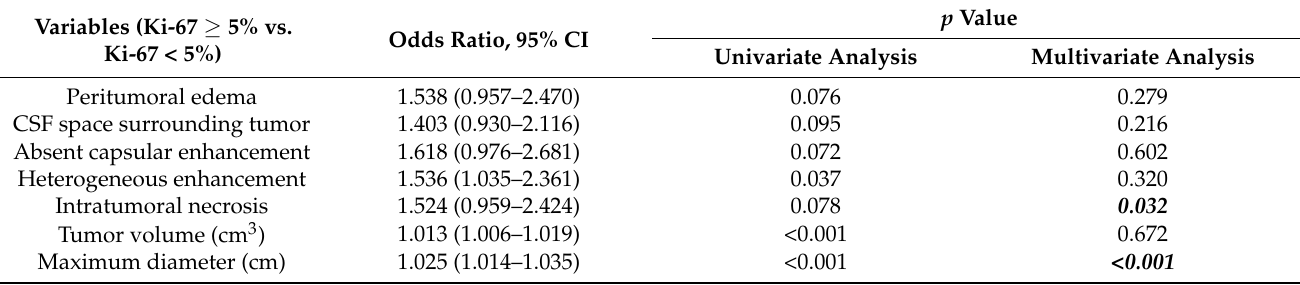
Table 2. Univariate and multivariate statistical analyses of clinical and radiological features. Variables (Ki-67 ≥ 5%